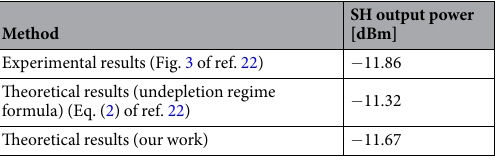
Table 1. Comparison results for EFISHG effect in straight waveguide operating at pump and SH wavelength of 2.29 µ m and 1.145 µ m.